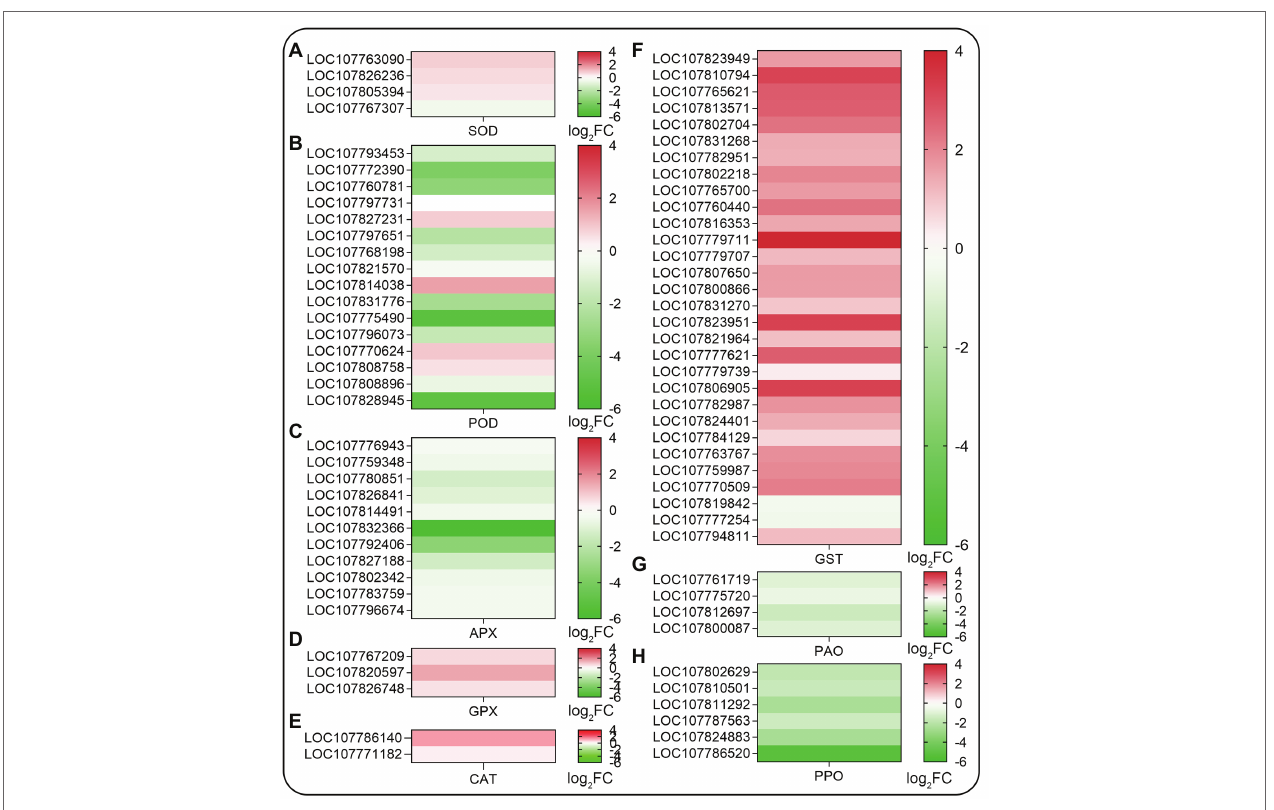
FIGURE 6 | Heat map diagrams of relative expression levels of reactive oxygen species (ROS) scavenging-related genes in response to SHAM treatment. (A) SOD, superoxide dismutase; (B) POD, peroxidase; (C) APX, ascorbate peroxidase; (D) GPX, glutathione peroxidase; (E) CAT, catalase; (F) GST, glutathione S -transferase; (G) PAO, polyamine oxidase; and (H) PPO, polyphenol oxidase. log 2 FC, log 2